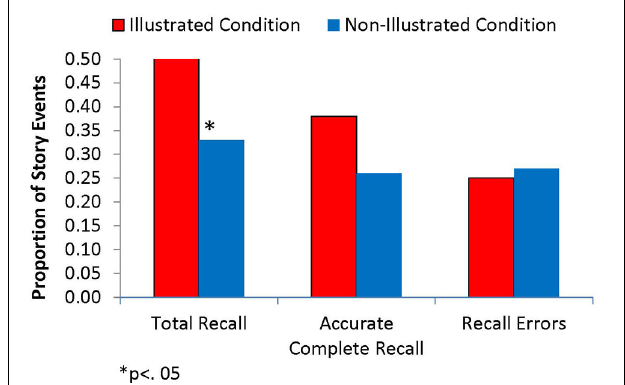
FIGURE 2 | Recall performance at the immediate interview, by story-reading condition.